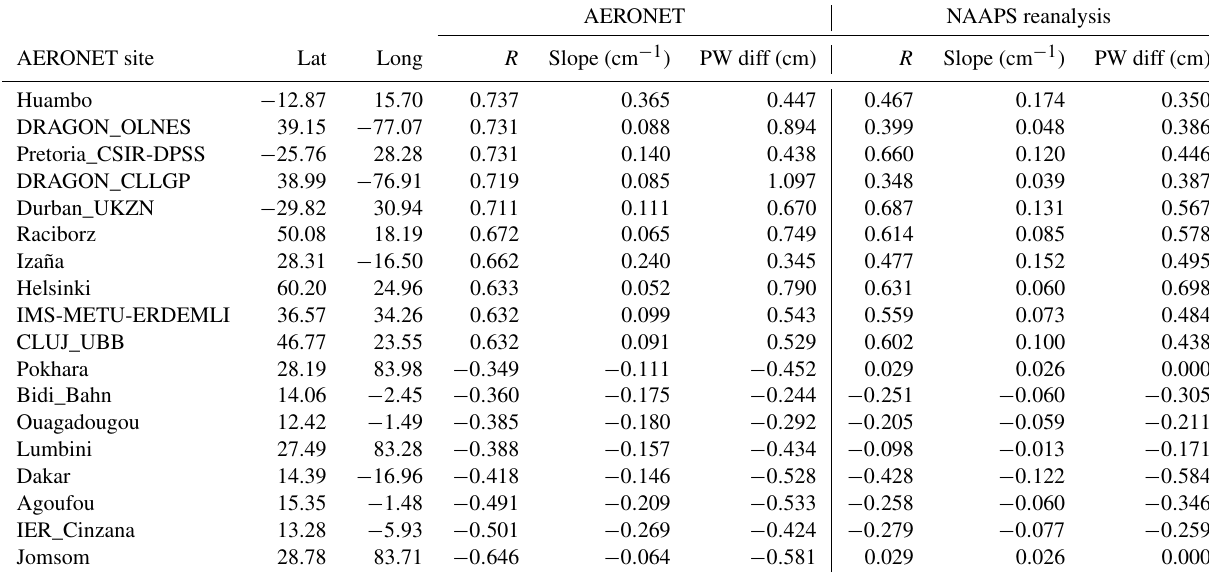
Table 3. AOD and PW relationship evaluation results for JJA at select AERONET sites that exhibited the strongest AERONET correlations, positive and negative. The site name and latitude–longitude information are shown, as well as the correlation ( R ), the change in AOD with PW (slope), and the statistically significant difference in mean PW for high-AOD events (PW diff) for both AERONET and the NAAPS-RA. PW difference values of 0 in the NAAPS-RA indicate the change was not statistically significant.